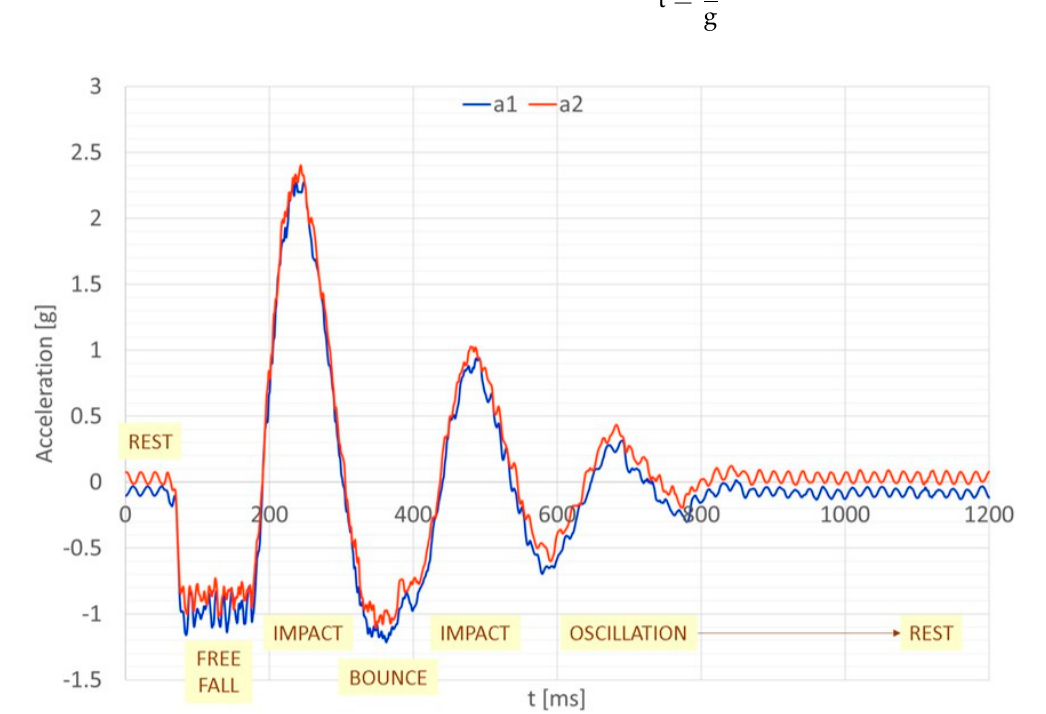
Figure 14. Typical accelerometer signals, as recorded during the drop tests. In this case, the starting height is set to 0.05 m.